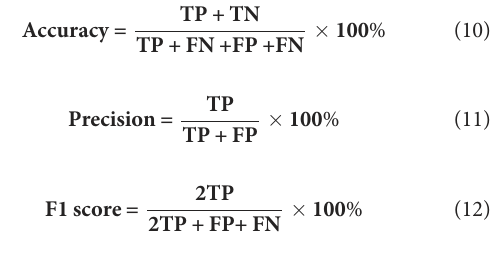
TABLE 1 The Grading Standards.